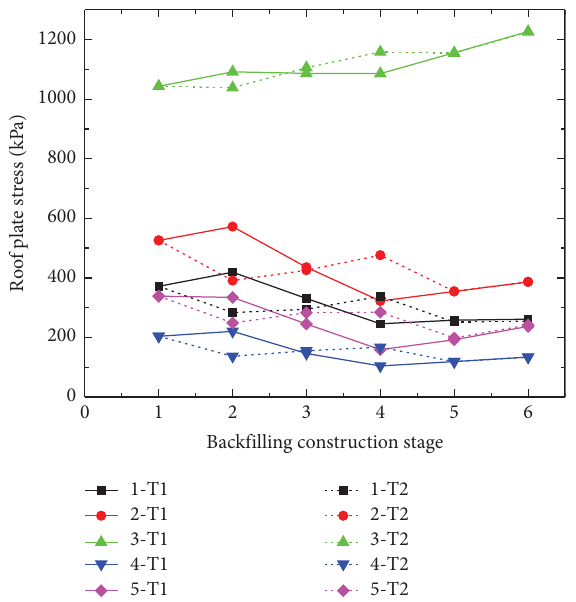
Figure 18: Te stress of the roof in the left-to-right backflling mode.